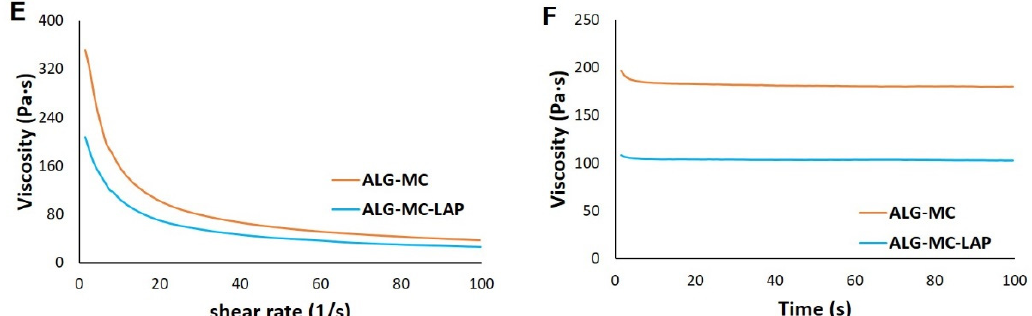
Figure 2. Rheological characterization of core and shell biomaterial inks. Representative plots showing the shear thinning behaviour of core—3% alginate and 3% Laponite loaded with antibiotics ( A , C ) and of shell—ALG-MC and ALG-MC-LAP ( E ). Viscosity of core and shell biomaterial inks, measured at a constant shear rate of 10 s − 1 over a period of 100 s ( B , D , F ), respectively.